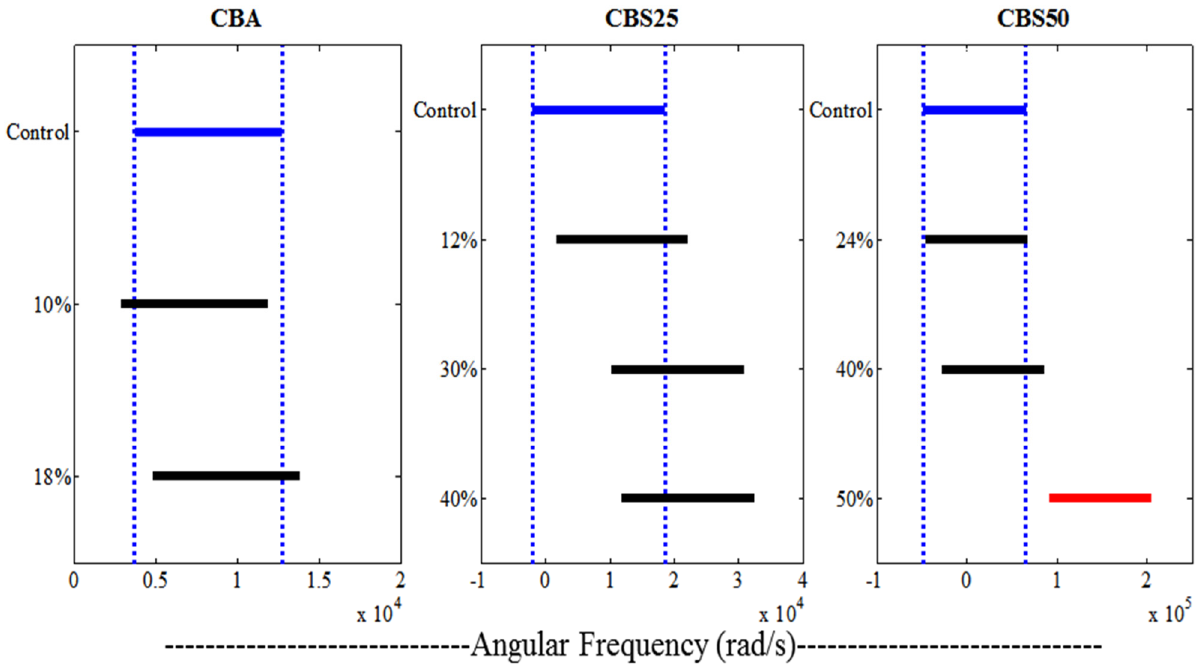
Figure 5. Analysis of Variance ( ANOVA) values of the rheological data presented in Figure 4. Vertical dotted lines indicate the level of statistical significance. Samples which fall outside of these margins (CBS 50 panel) are statistically different across their